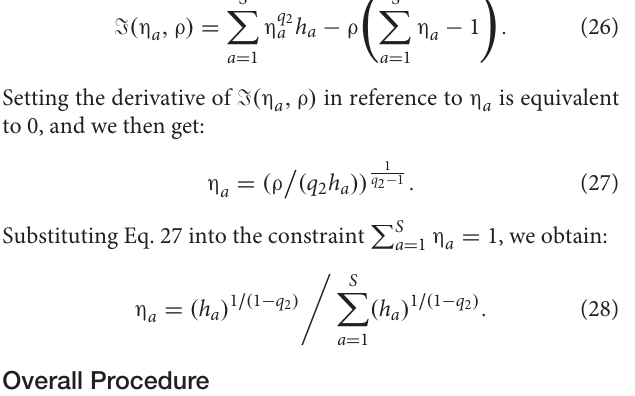
Algorithm 1. Multiple sources adaptation learning by utilizing correlation